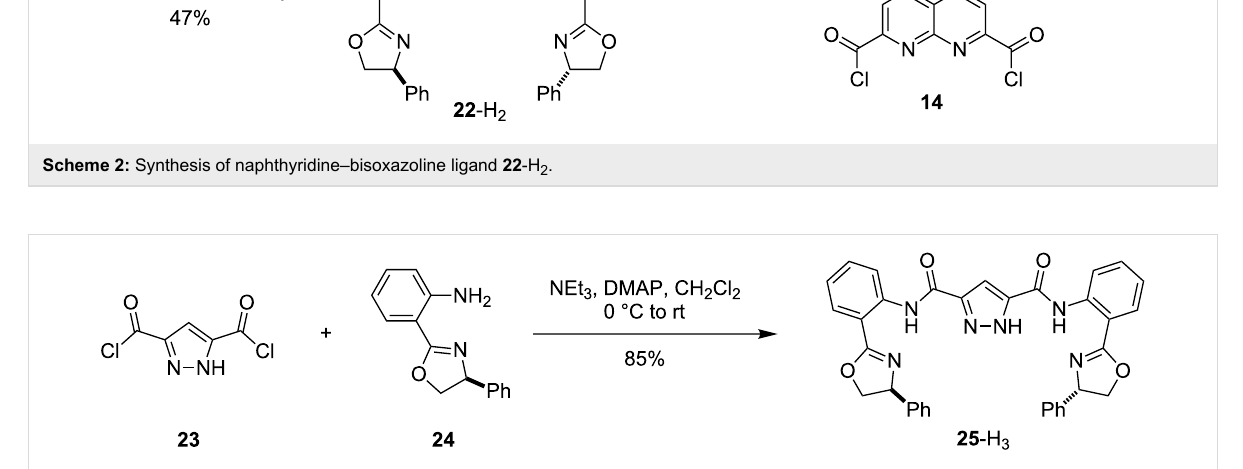
Scheme 3: Synthesis of pyrazole–bisoxazoline ligand 25 -H 3